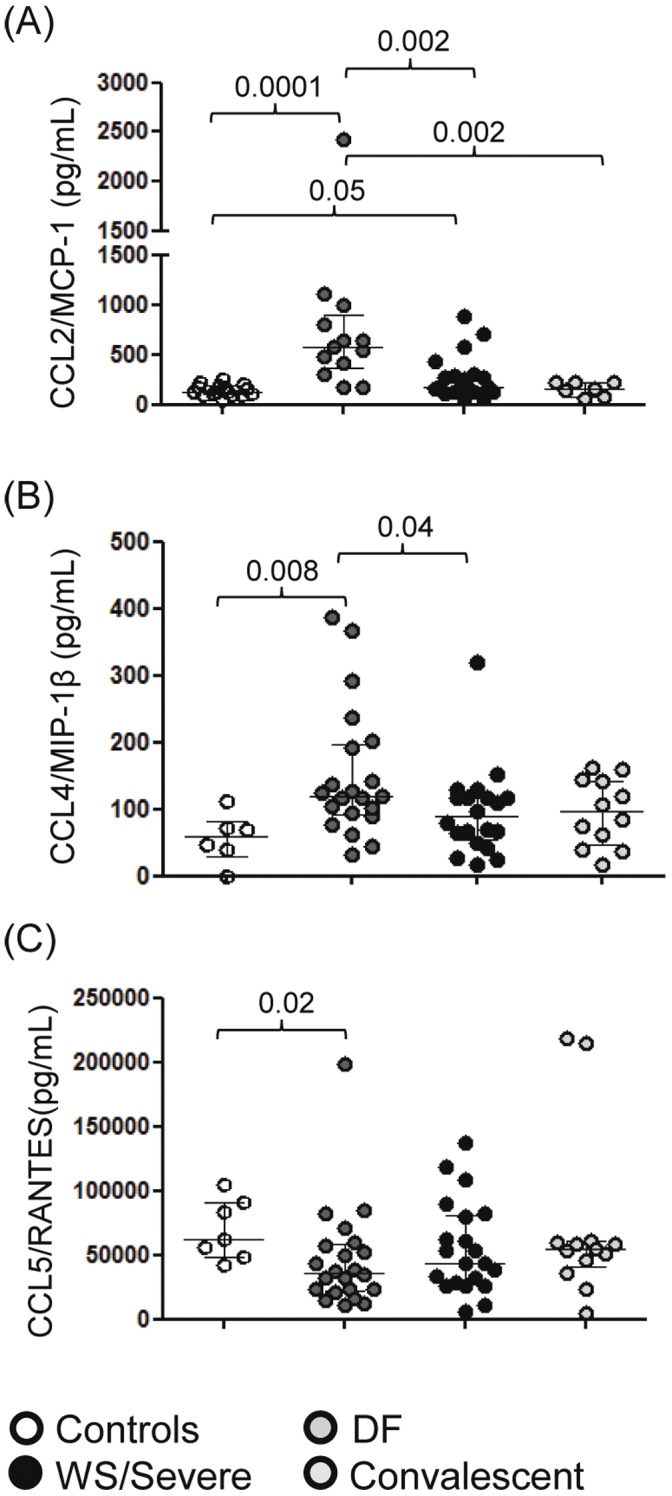
Circulating CCL2/MCP-1, CCL4/MIP-1β and CCL5/RANTES are differentially expressed DENV-patients.Each individual is represented, comparing healthy controls, acute or convalescent DENV-patients. The Mann–Whitney U-test was used to analyze differences between control and patient groups. Statistically significant P values for differences between patients and controls are given above the figures.